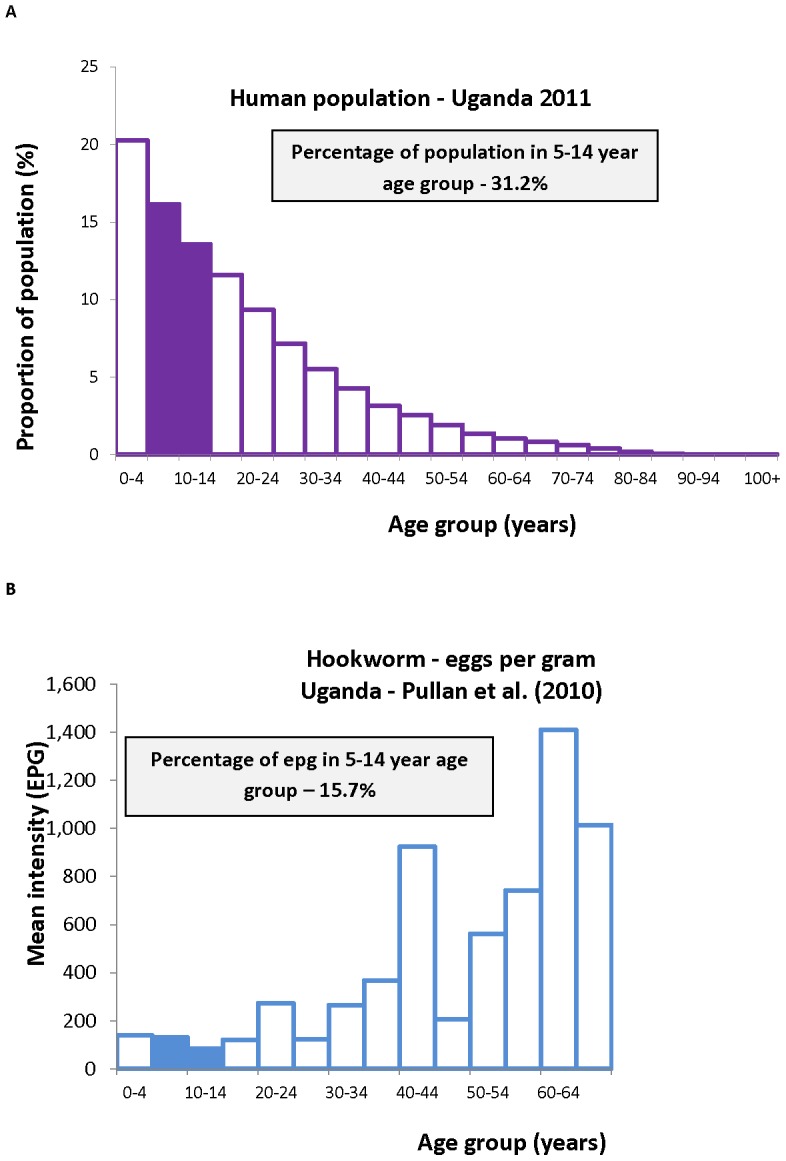
The proportion of hookworm eggs deposited by children aged 5–14, calculated from
equation 5
.The demography of the population, A, gives a proportion of 31.2% of the population aged 5–14 years old [45]. Combining this distribution with B the distribution of egg output by age [36] gives 15.7% of worms in the school-aged group.